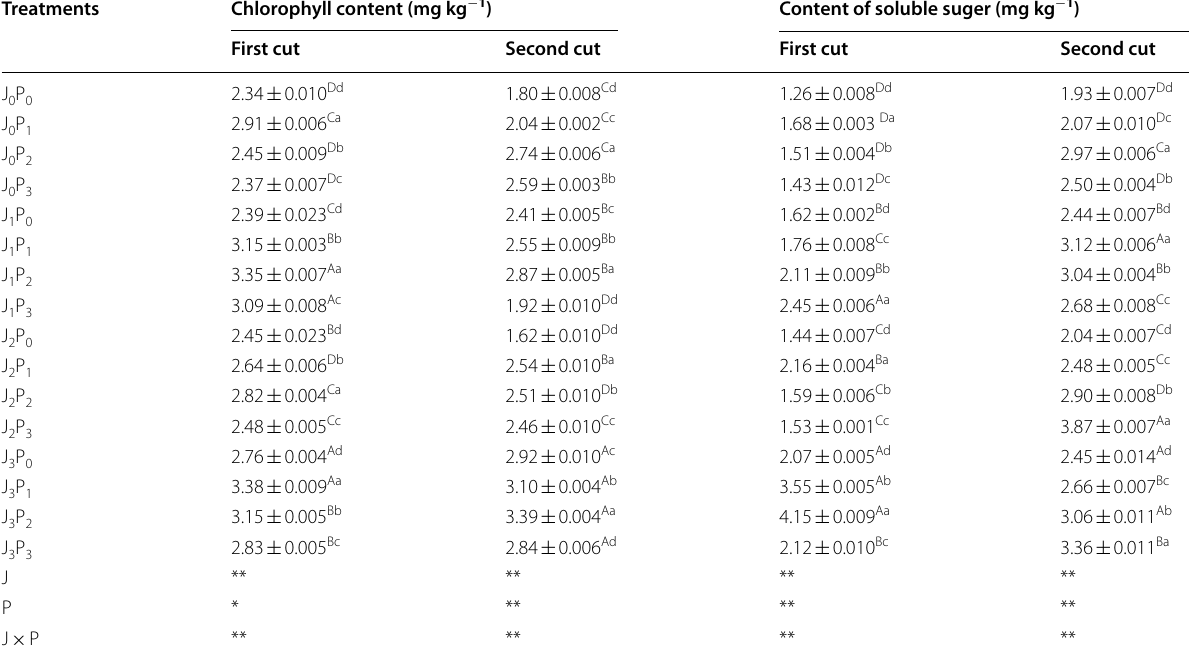
Different capital letters in the same column indicated significant difference in different bacteria treatments under the same phosphorus application conditions ( P < 0.05), differences small letters in the same column mean significant difference under the same bacteria application conditions ( P < 0.05). ** indicates significant difference extremely ( P < 0.01)